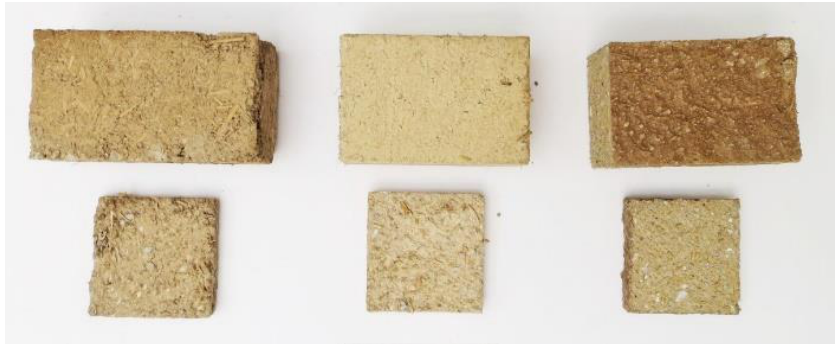
Figure 34. The appearance of hardened mixtures (halves of 4 × 4 × 16 cm beams) on the surface and in the cross section, E — left, EL — middle, ELC — right.